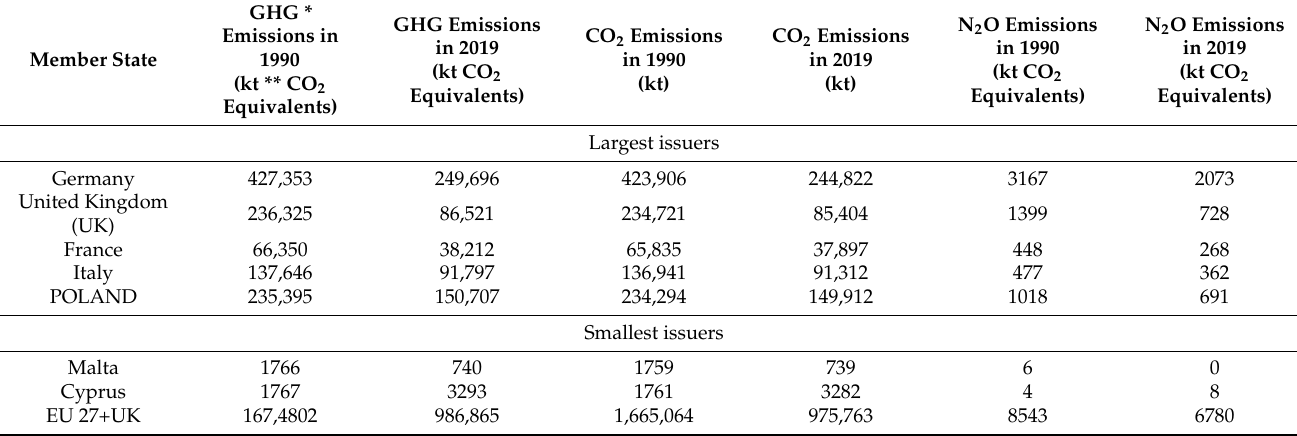
Table 6. Energy industry: contribution of the largest and smallest emitters to CO 2 and N 2 O emissions in EU countries [32].